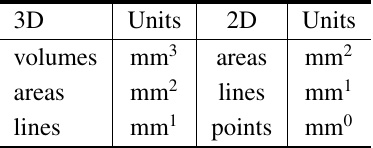
3D representation in 2D (see Figure